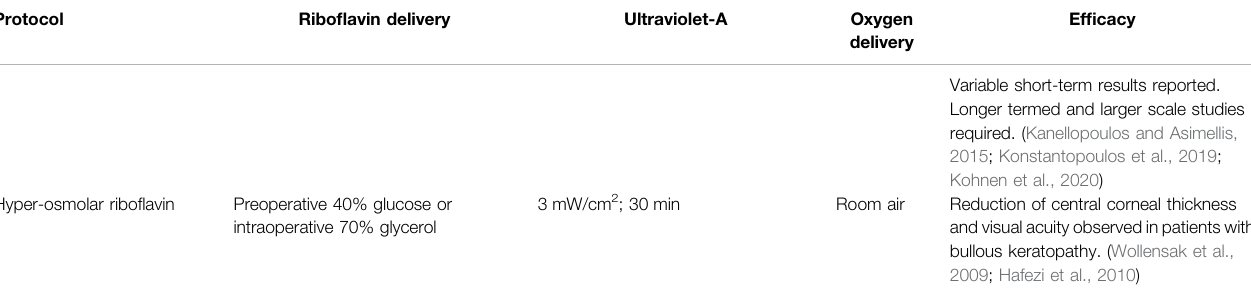
TABLE 1 | ( Continued ) Summary of existing corneal cross-linking